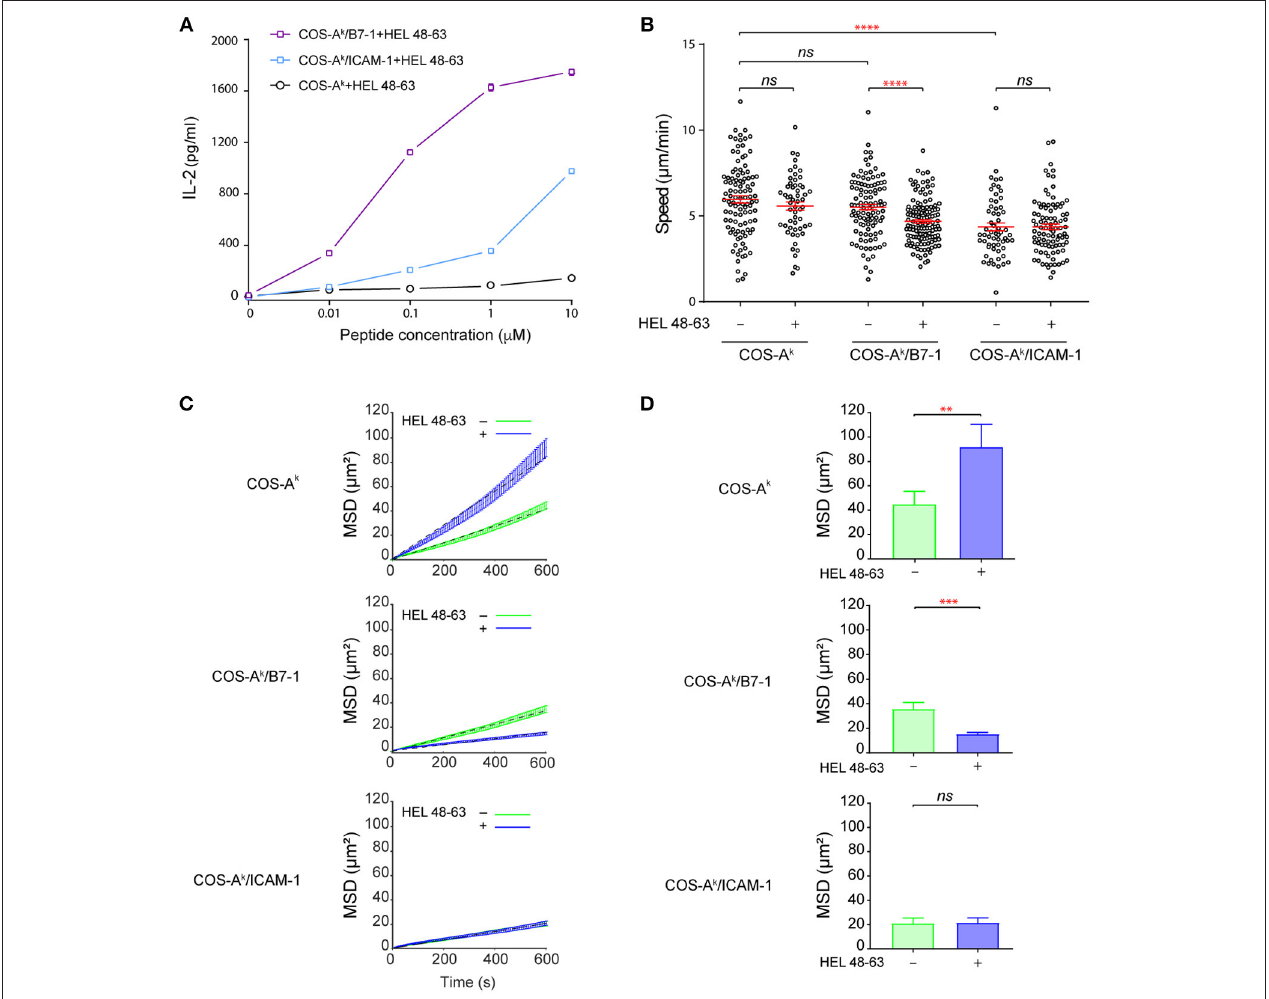
FIGURE 1 | B7-1 expression on COS APCs provides efficient costimulatory signaling to naive CD4 + T cells. (A) Activation of naive CD4 + T cells upon contact with COS APCs loaded with HEL 48–63 peptides. 5 × 10 5 naive CD4 + T cells from 3A9 TCRtg mice were cultured at 37 ◦ C with COS-A k , COS-A k /B7-1, COS-A k /ICAM-1 cells, loaded or not with different doses of HEL 48–63. T cells were harvested after 20h. IL-2 concentration in the supernatants was measured by ELISA. Data represented the mean of three individual experiments. Data: mean ± s.d. (B) Naive CD4 + T cells form mobile contacts with COS APCs loaded or not with HEL 48–63. Naive CD4 + T cells from 3A9 TCRtg mice were loaded onto APCs monolayers of COS-A k , COS-A k /B7-1, COS-A k /ICAM-1 cells grown to confluency on Lab-Tek chamber slide, loaded or not with 1 µ M HEL 48–63. T cell trajectories were recorded for 45min at 37 ◦ C using confocal video-microscope. Average migration speed over the whole trajectory was calculated as described in Materials and Methods. Data: mean ± SEM. Their numerical values were 5.96 ± 0.21 µ m/min ( n = 105), 5.57 ± 0.24 µ m/min ( n = 56), 5.59 ± 0.18 µ m/min ( n = 111), 4.68 ± 0.11 µ m/min ( n = 134), 4.36 ± 0.23 µ m/min ( n = 60), and 4.36 ± 0.17 µ m/min ( n = 93) for the T cells contacting with COS-A k , COS-A k plus HEL 48–63, COS-A k /B7-1, and COS-A k /B7-1 plus HEL 48–63, COS-A k /ICAM-1, and COS-A k /ICAM-1 plus HEL 48–63, respectively. ( C) Mean square displacement over time and (D) average mean square displacement over 10min of T cells seeded onto COS-A k , COS-A k /B7-1, and COS-A k /ICAM-1 cells, loaded or not with 1 µ M HEL 48–63, respectively. Mann–Whitney tests were performed using Graphpad prism 7.0 for comparisons between two groups. Statistical significance was set at 0.05, and p -values < 0.05 were denoted in red. ** p < 0.01, *** p < 0.001, and **** p < 0.0001.